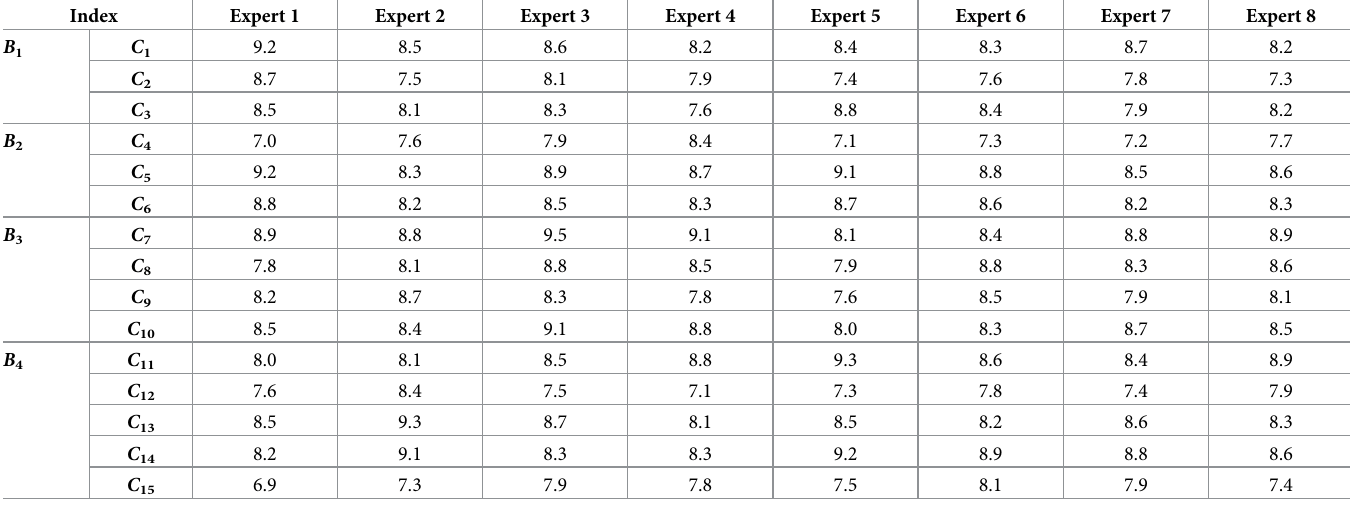
Table 4. Second-class index